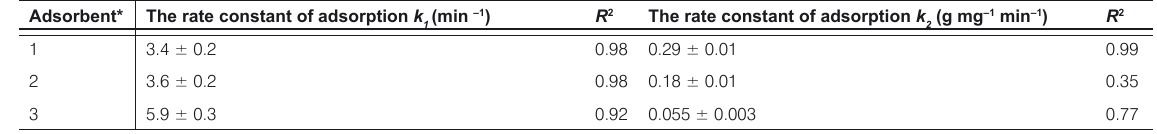
Table 3. The kinetic characteristics of mercury(II) nitrate adsorption for processes of pseudo-first and pseudo-second order in Lagergren model.